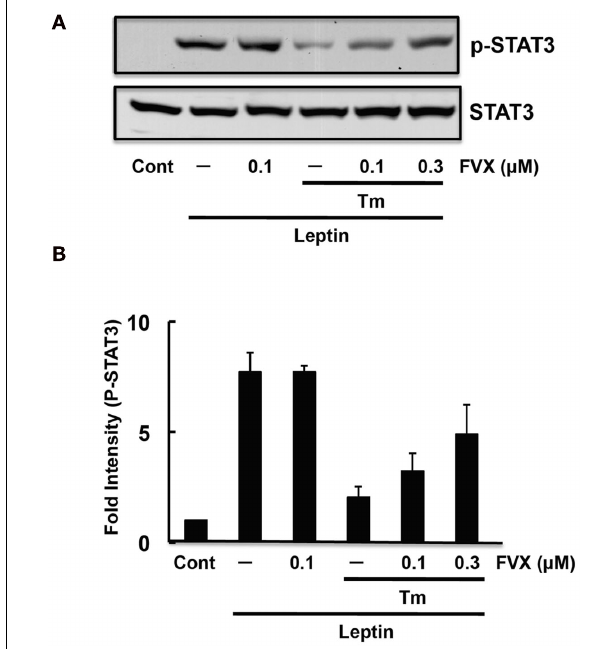
FIGURE 3 | Fluvoxamine restored ER stress-induced leptin resistance. (A) SH-SY5Y–Ob–Rb cells were pre-treated with fluvoxamine (FVX: 0.1 μ M) for 1h and then treated with tunicamycin (Tm: 0.5 μ g/mL). Four hours after the tunicamycin treatment, the cells were stimulated with leptin (Lep: 0.5 μ g/mL) for 15min and the phosphorylation status of STAT3 was analyzed.Western blotting was performed using specific antibodies for phospho STAT3 and STAT3. (B) Densitometric analysis of STAT3 phosphorylation using image analyzing